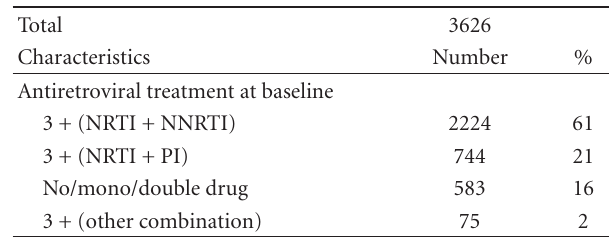
Table 2: Patient characteristics. Table 2: